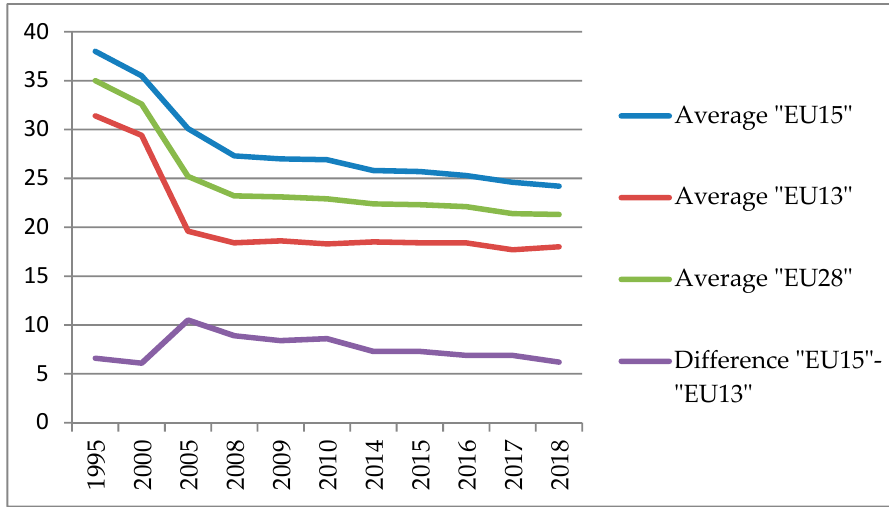
Figure 1. Dynamics of the corporate tax in the EU.